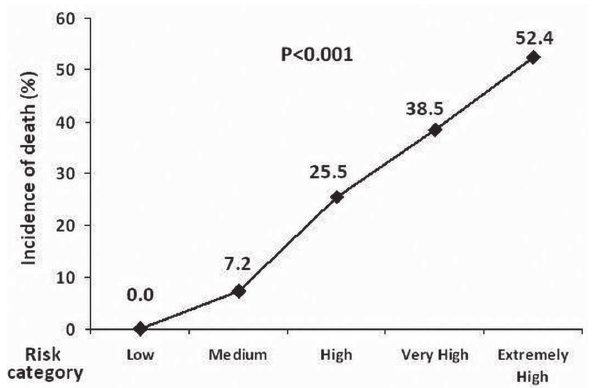
Fig. 2 - Relationship between the risk group classification according to the score and incidence of death. Note the upward curve as it increases the risk class